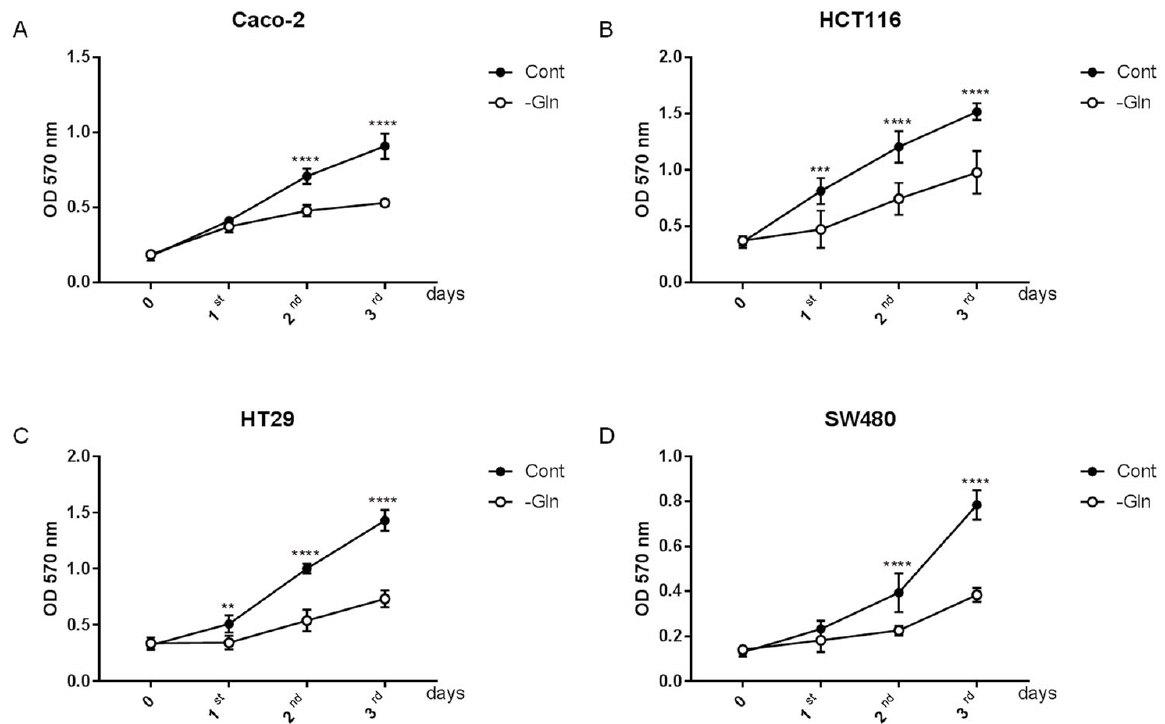
Figure 1. Growth curves of colorectal cancer cell lines (( A ) Caco-2, ( B ) HCT116, ( C ) HT29, ( D ) SW480) under glutamine starvation for 3 days. Cell viability was assessed by MTT assay at the indicated time points in the presence ( • ) or absence (o) of glutamine in the medium. Representative growth curves of three independent experiments are shown. Data are presented as mean ± standard deviation (SD) ( n = 3, ** p < 0.005, *** p < 0.0005, **** p < 0.0001 compared to Cont). Table 2. Cell viability after 3 days of glutamine starvation in colorectal cancer cell lines.